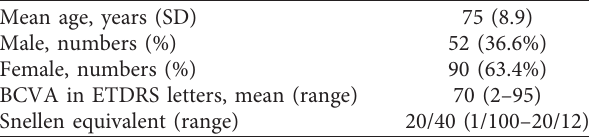
Table 1: Demographics of patients enrolled in this study.